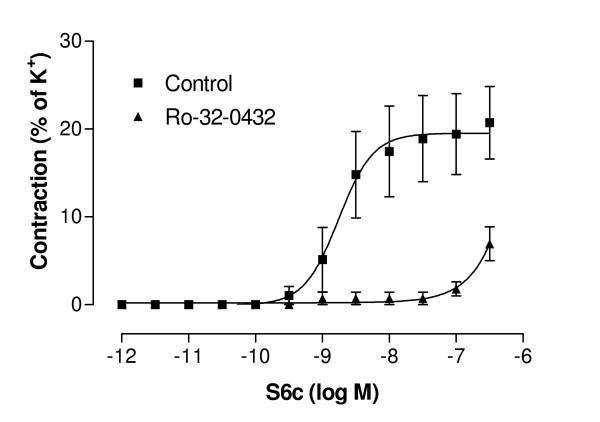
Contractile responses to S6c in the RMCA of vehicle or Ro-32-0432 treated rats after MCAO. The ischemia resulted in S6c induced contractile responses due to ETB receptor upregulation, which Ro-32-0432 was able to attenuate. Values represent means ± S.E.M., n = 4–6 (for details see Table 3).